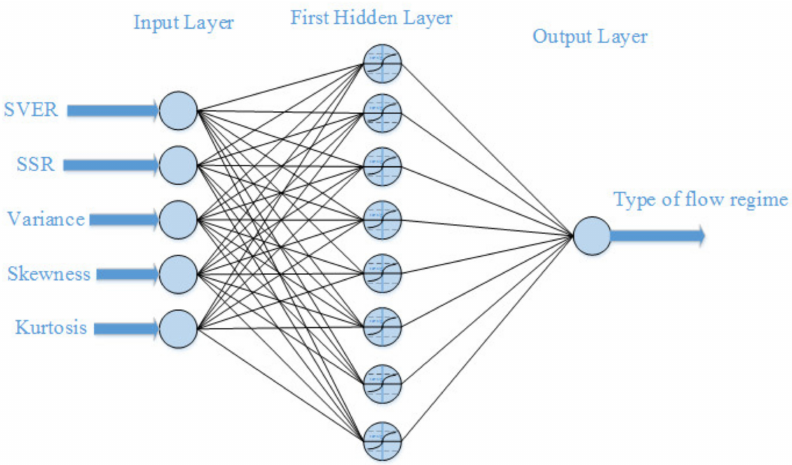
Figure 9. The configuration of presented ANN for classifying the flow